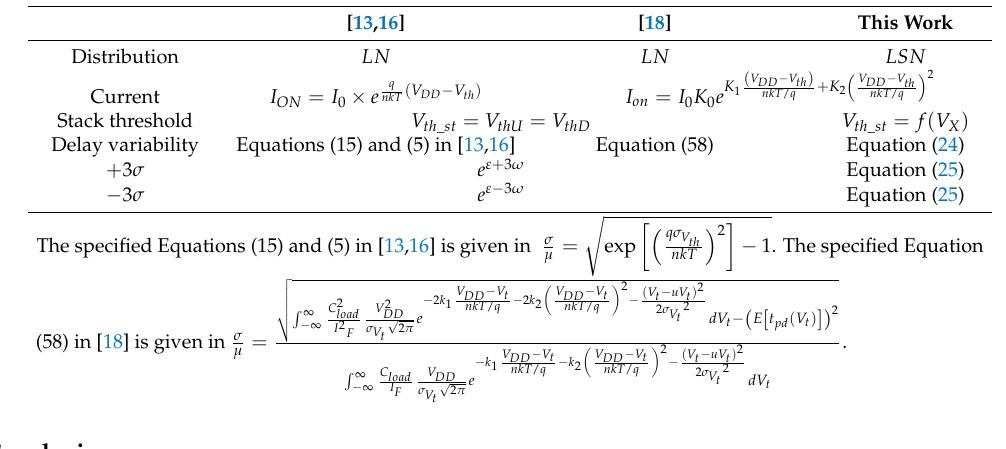
Table 3. Comparison of methods in different